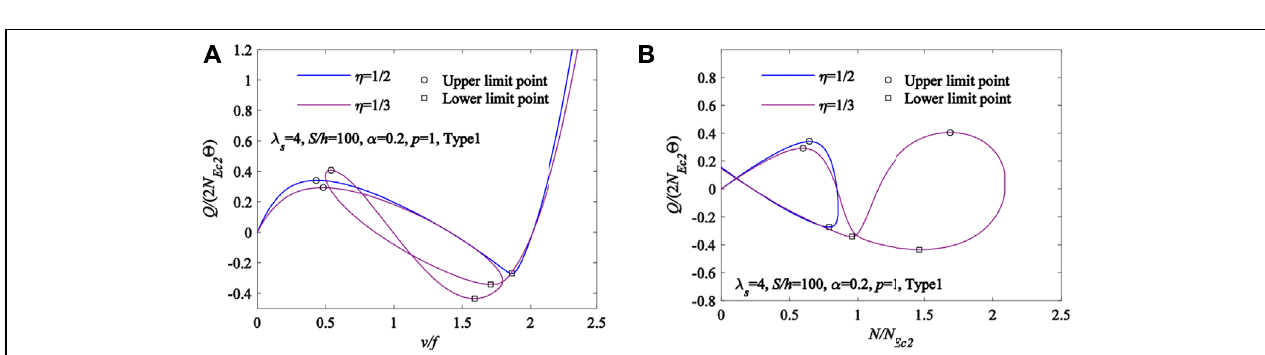
FIGURE 5 | Inflection point of limit point instability for pin-ended FGM arches using different types of cross-section: (A) v / f − Q /(2 N Ec 2 Θ ) curves. (B) N / N Ec 2 − Q /(2 N Ec 2 Θ ) curves.